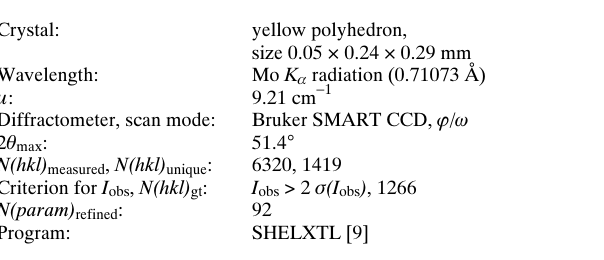
Table 1. Data collection and handling.